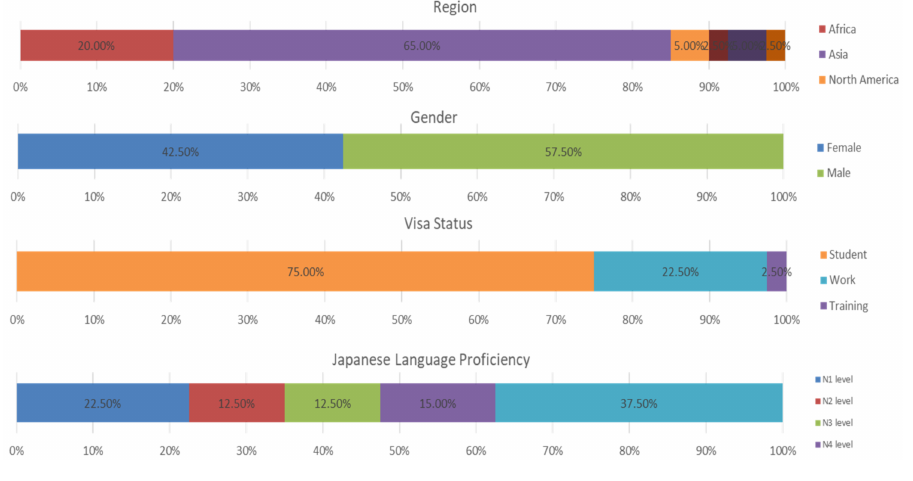
Figure 2. Demographic characteristics.